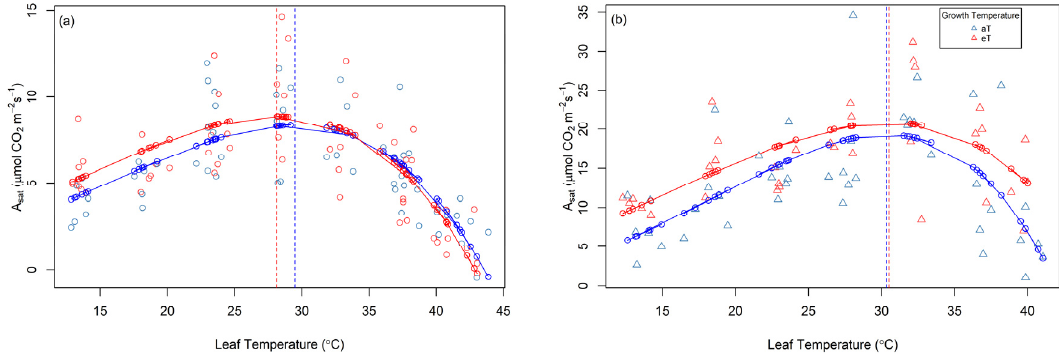
Figure 4. Short-term temperature response of light-saturated net photosynthesis (A sat ) for ( a ) tall fescue and ( b ) lucerne grown under 26 °C (aT, blue) and 30 °C (eT, red). Blue and red lines indicate the temperature response function for the 26°C and 30 °C growth temperature treatments, respectively. Vertical dashed lines represent the T opt for each species grown under aT (blue) and eT (red). 3.4. WUE